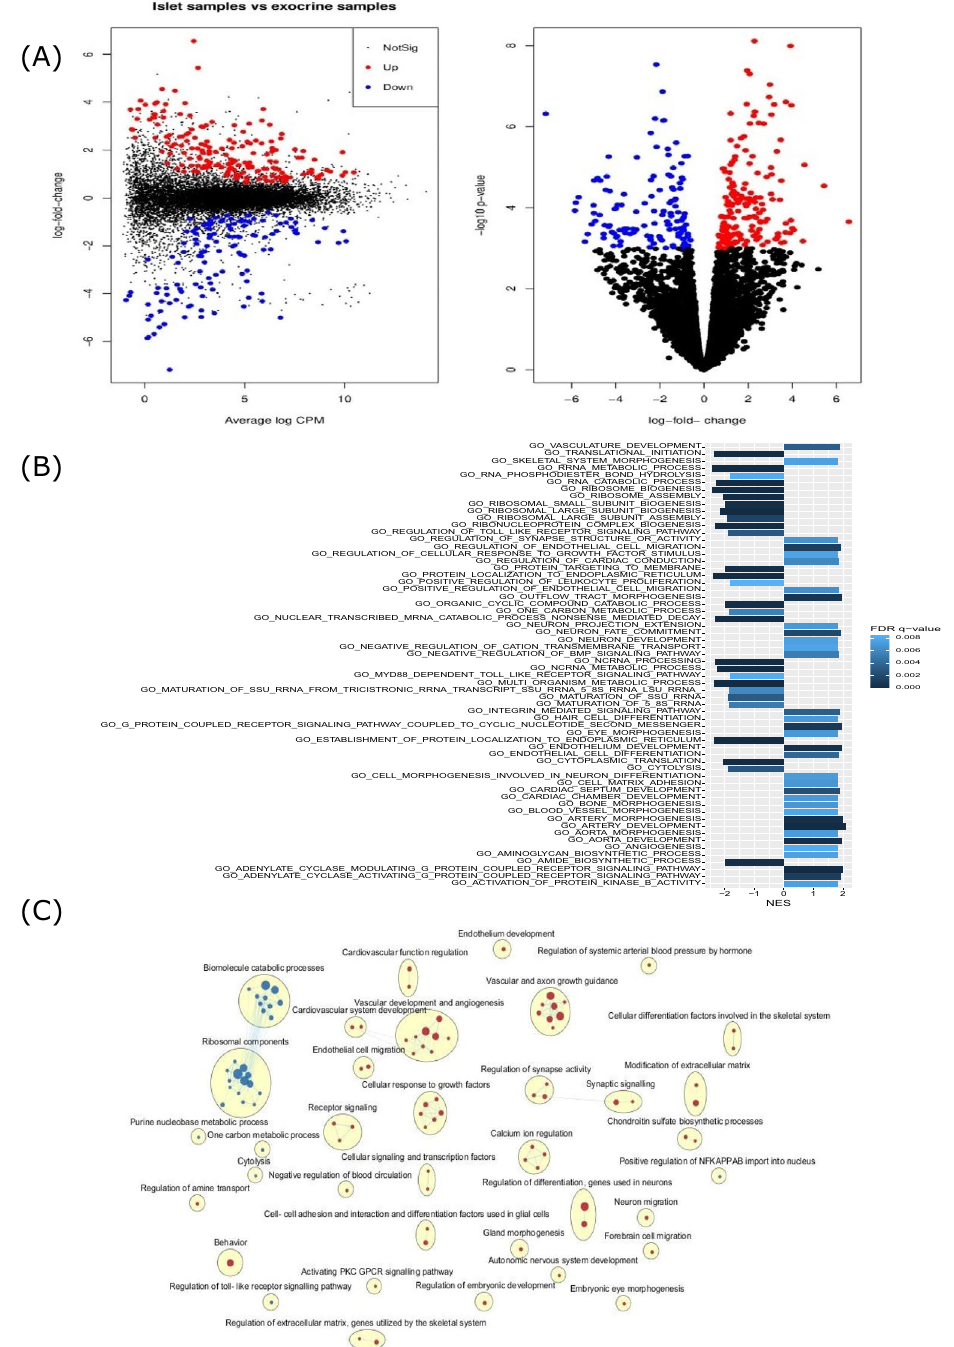
Figure 3. ( A ) Left: Mean difference plot comparing gene expression in islet- and exocrine MVEC samples, displaying log fold change and logCPM. Right: Volcano plot illustrating the logFC and log p-values of the same data, as estimated using a generalized linear model test for differential expression relative to a threshold (glmTREAT). Genes with a fold change of at least 1.2 at FDR < 0.05 are highlighted in red (indicating islet MVEC enrichment) or blue (indicating exocrine MVEC enrichment). n = 12 (islets) and 12 (exocrine). ( B ) The top enriched gene sets (FDR < 0.01) as determined with gene permutation pre-ranked GSEA, with the x-axis displaying normalized enrichment score (NES) and the color of the bar indicating the FDR q-value. A NES > 0 indicates enrichment in islet MVEC samples, a NES < 0 indicates enrichment in exocrine MVEC samples. n = 12 (islets) and 12 (exocrine). ( C ) Enrichment map showing relations between enriched gene sets (with FDR < 0.01 and nominal p-value < 0.005) as determined by gene permutation pre-ranked GSEA. Each gene set is represented by a node (red and blue dots for islet MVEC and exocrine MVEC enrichment respectively). Enriched gene sets have been hierarchically clustered, and most clusters (yellow ellipses) have been manually annotated. Edge widths indicate the degree of overlap between gene sets. The sizes of the circles are proportional to the number of genes in the gene set. n = 12 (islets) and 12